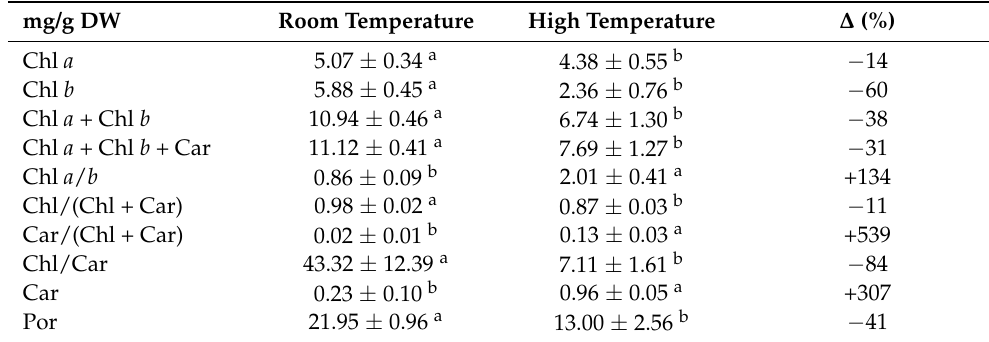
Values represent mean ± standard deviation of three biological replicates and three technical replicas. Dif- ferent letters indicate a significant difference among the values in a row (ANOVA, Duncan’s test, p ≤ 0.05). Chl = chlorophyll; Car = carotenoids; Por =